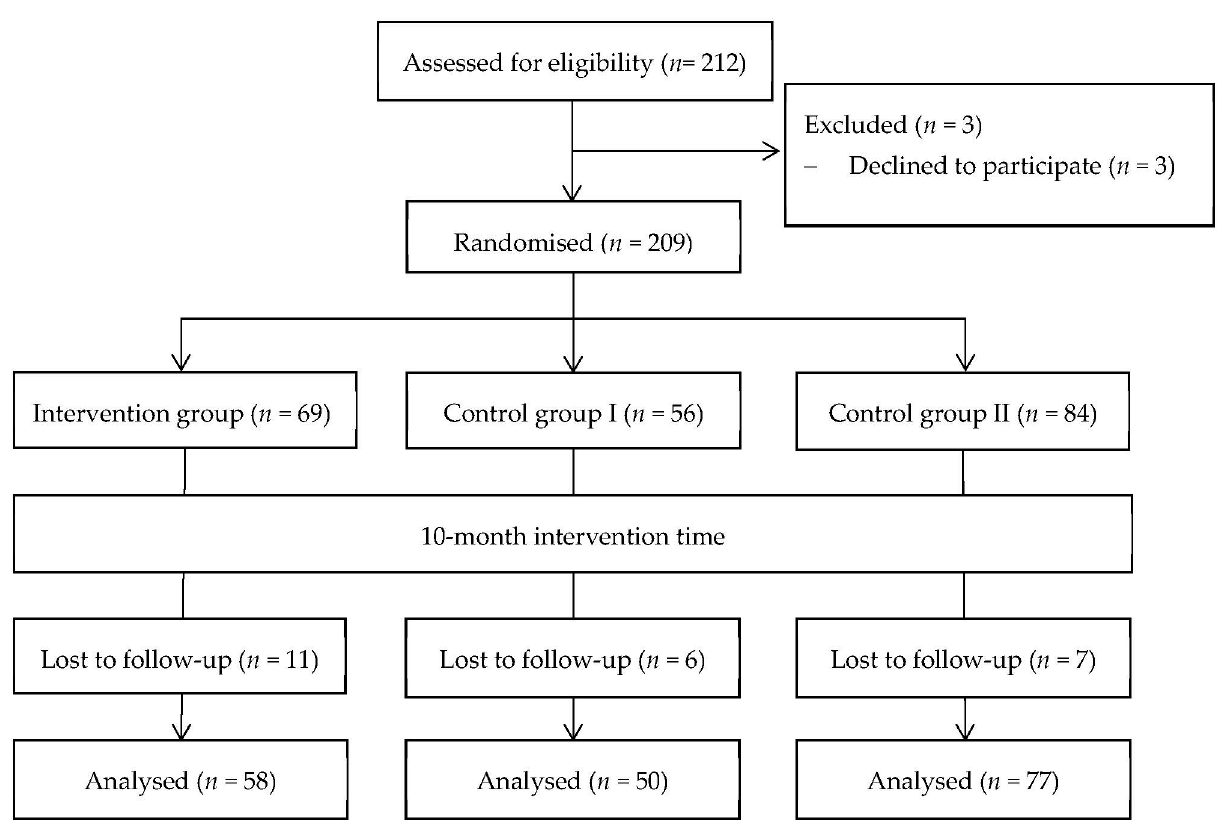
Figure 1. CONSORT flow diagram of participants included and excluded during the course of the project.